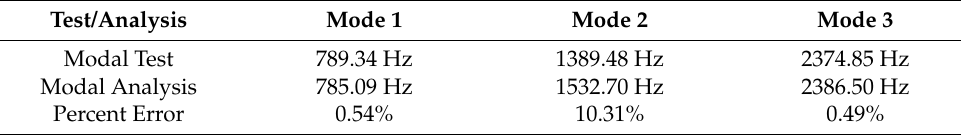
Table 5. Comparison of test and analysis results for the coil Type-1.